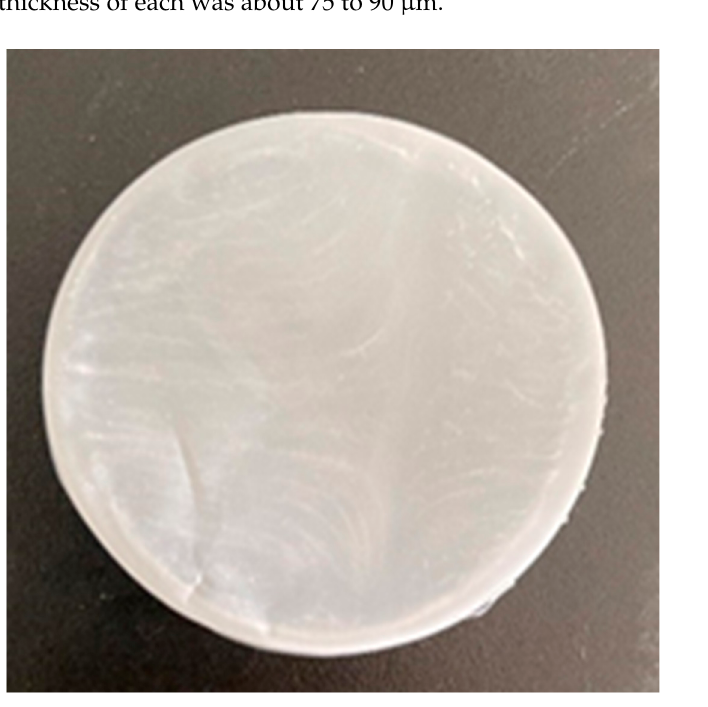
Figure 9. Image of a ZIF-8@BNNS /Pebax mixed matrix membrane.